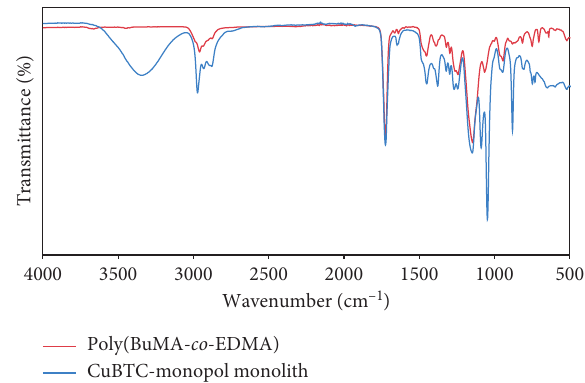
Figure 7: FT-IR spectra of bare organic monolithic material and CuBTC-monopol monolith.